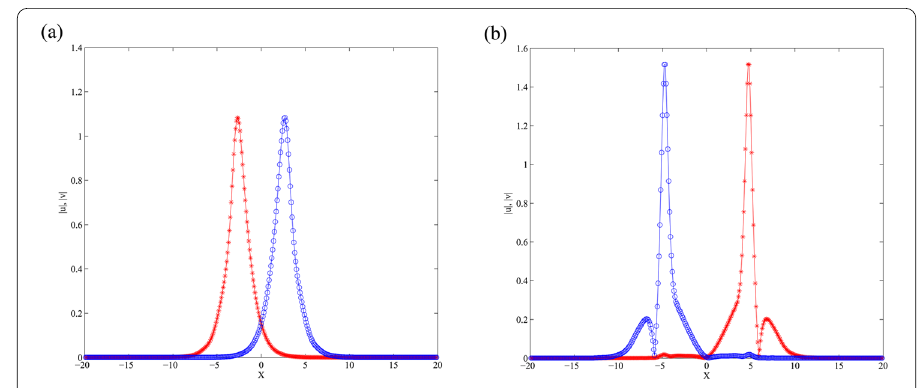
Figure 4 The numerical solutions at different t for α = 0.75; ( a ): t = 1, ( b ): t = 4; red stars: | u | , blue circles: | v |